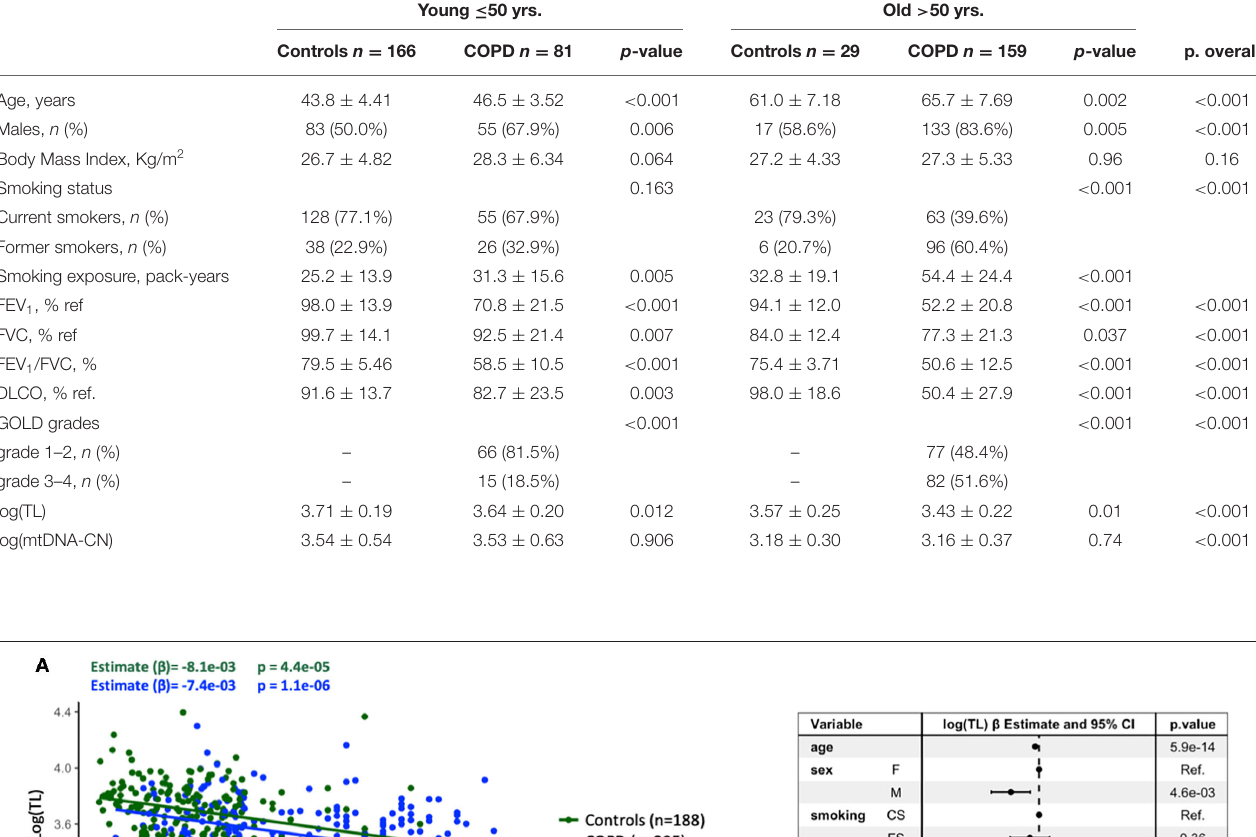
TABLE 1 | The characteristics of the participants [mean ± SD or number (%)]. Young ≤ 50 yrs. Old > 50 yrs.